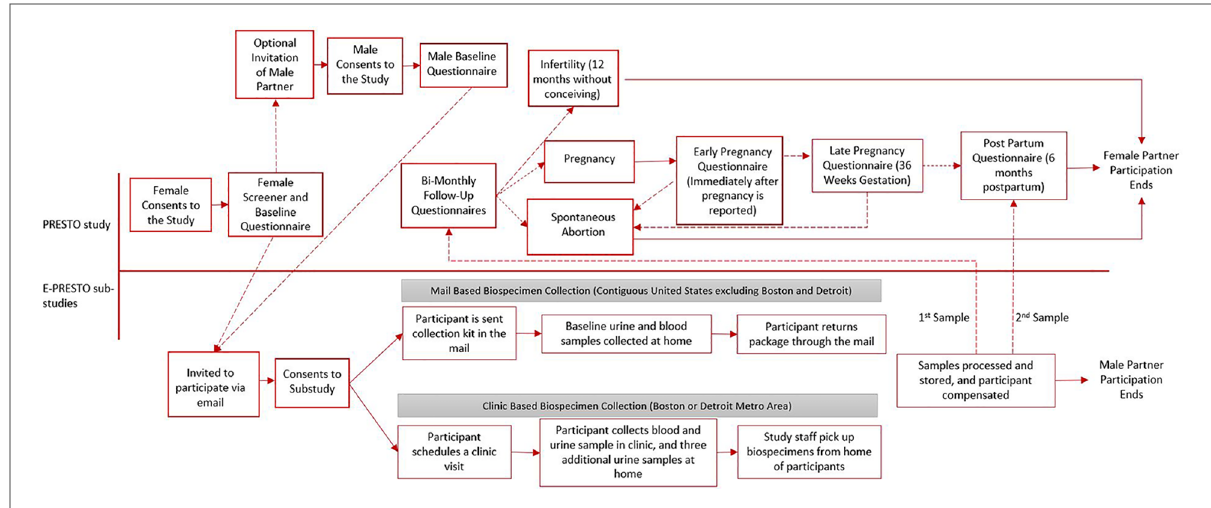
FIGURE 1 Timeline of study procedures and data collection for PRESTO and E-PRESTO